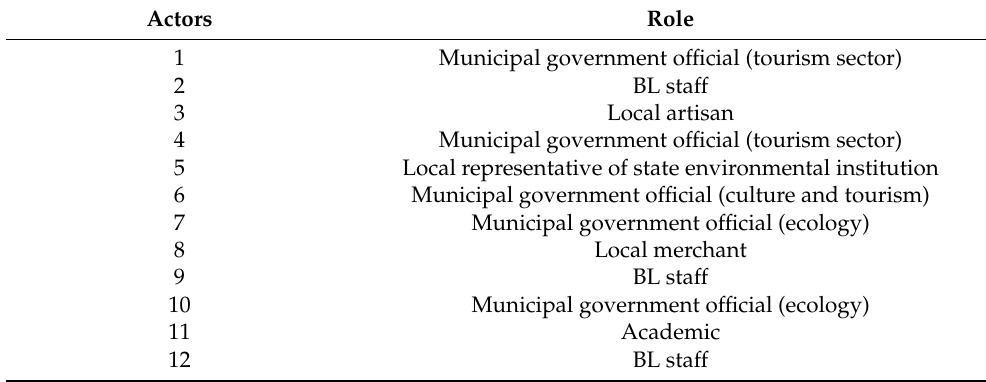
Table 1. Roles of the interviewed